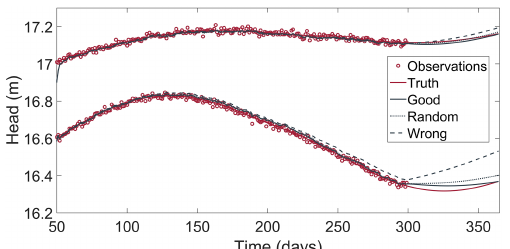
Figure 7. Two head observations plotted over time for the joint esti- mation of recharge and conductivity. Shown is the ensemble mean. Assimilation is performed from day 50 to day 300, while the re- maining days are considered for